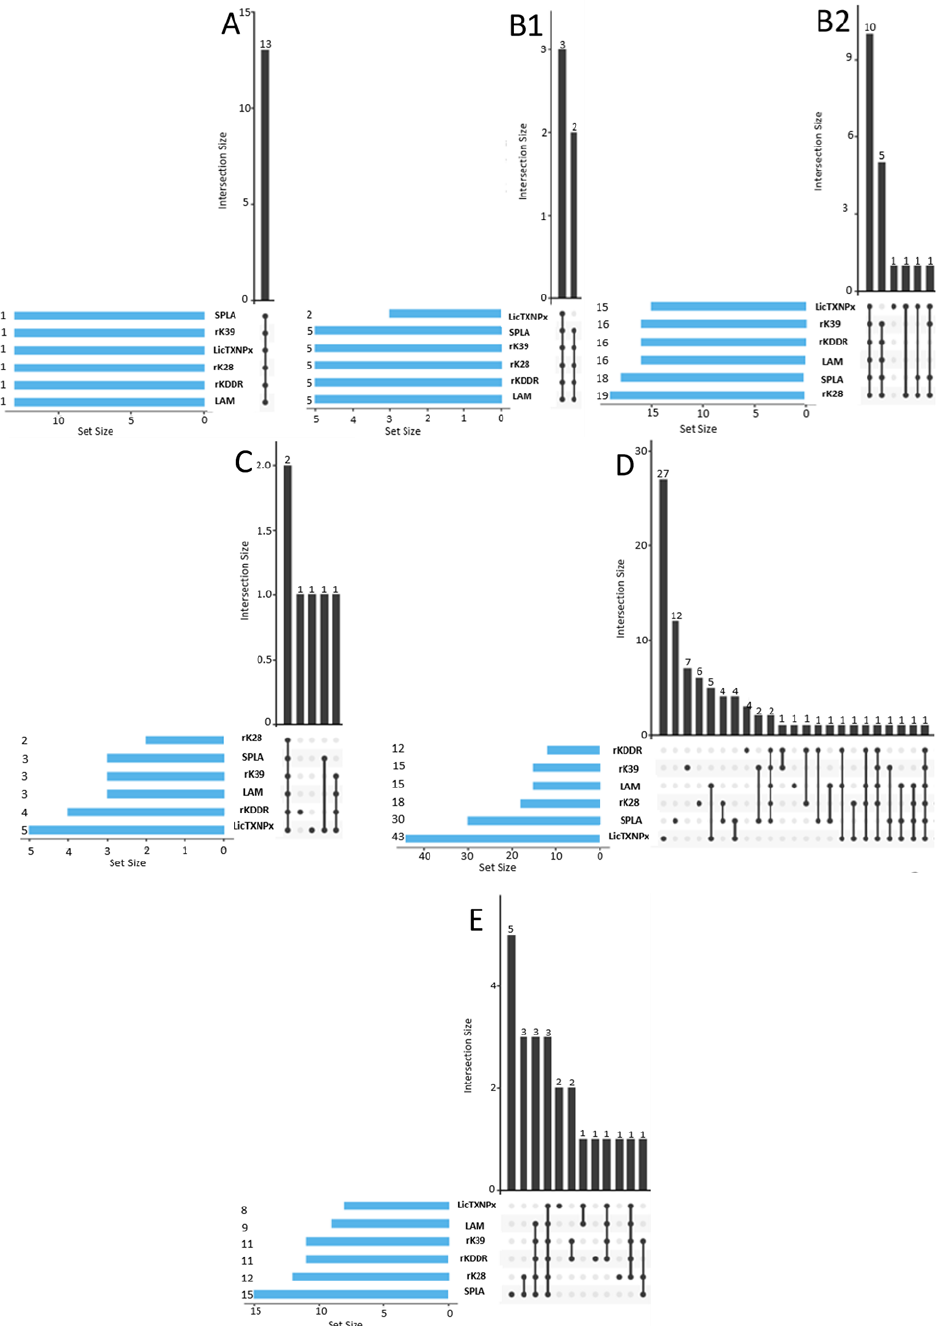
Figure 3. UpSet Plot depicting seropositivity intersect to rKDDR, LAM, rK39, rK28, SPLA, and LicTXNPx in the cohorts used to subdivide the PT cohort ( A , B1 , B2 , C , D , and E ). The black bars in the graph represent the absolute number of positive events of each intersection, associated with the six parameters evaluated. Under each black bar, the connecting line represents the intersection of the tested parameters. If no intersecting line is present it means that dogs only positive to one event are being quantified in the upper black bar. To the left, the blue bars represent the absolute number of dogs that are positive for each individual characteristic evaluated. In each individual graphic the antigens are ordered by increasing number of seropositive